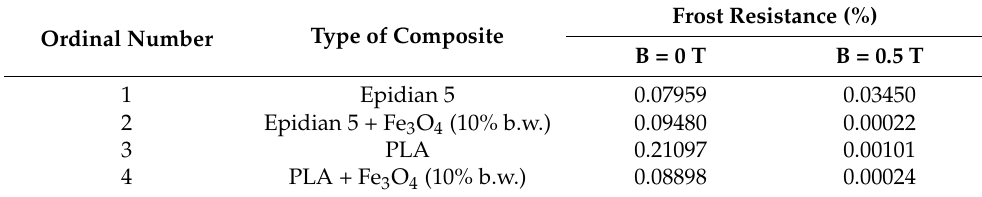
Table 4. Frost resistance of